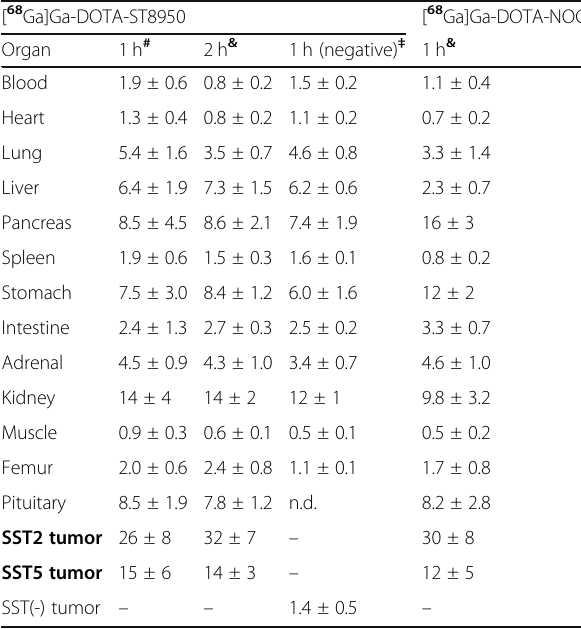
Table 4 Biodistribution results of [ 68 Ga[Ga-DOTA-ST8950 at 1 and 2 h p.i. and [ 68 Ga]Ga-DOTA-NOC at 1 h